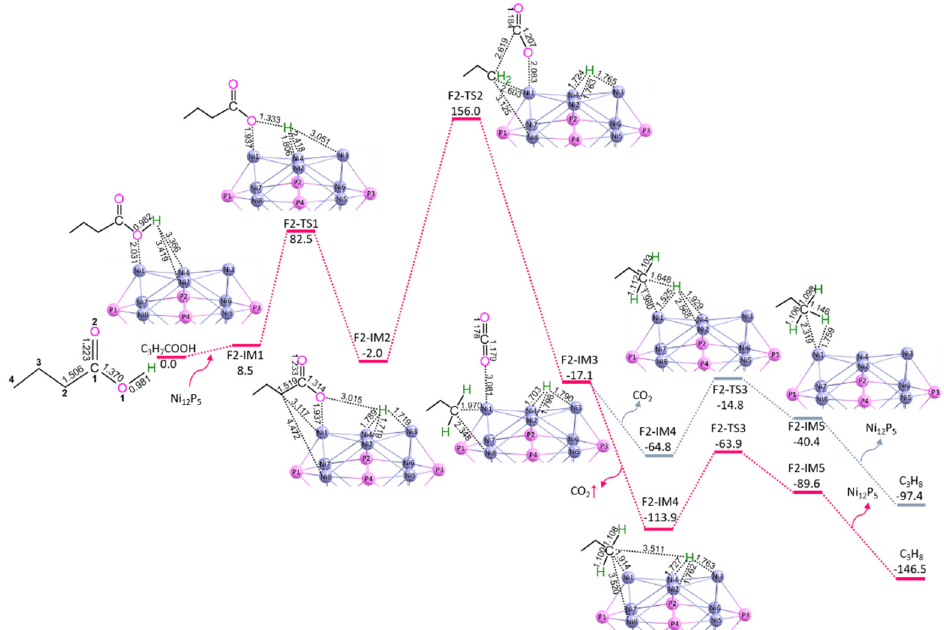
Figure 2. The potential energy curves with the relative Gibbs free energy ( G r , kJ mol − 1 ) and the geo- metric structures with bond lengths (Å) for reaction stage S2 over Ni 12 P 5 cluster at GGA − PBE/DSPP, DNP level. For brevity, some hydrogen atoms are hidden. CO 2 ↑ shows the CO 2 pressure with 10 − 5 atm under experimental condition.